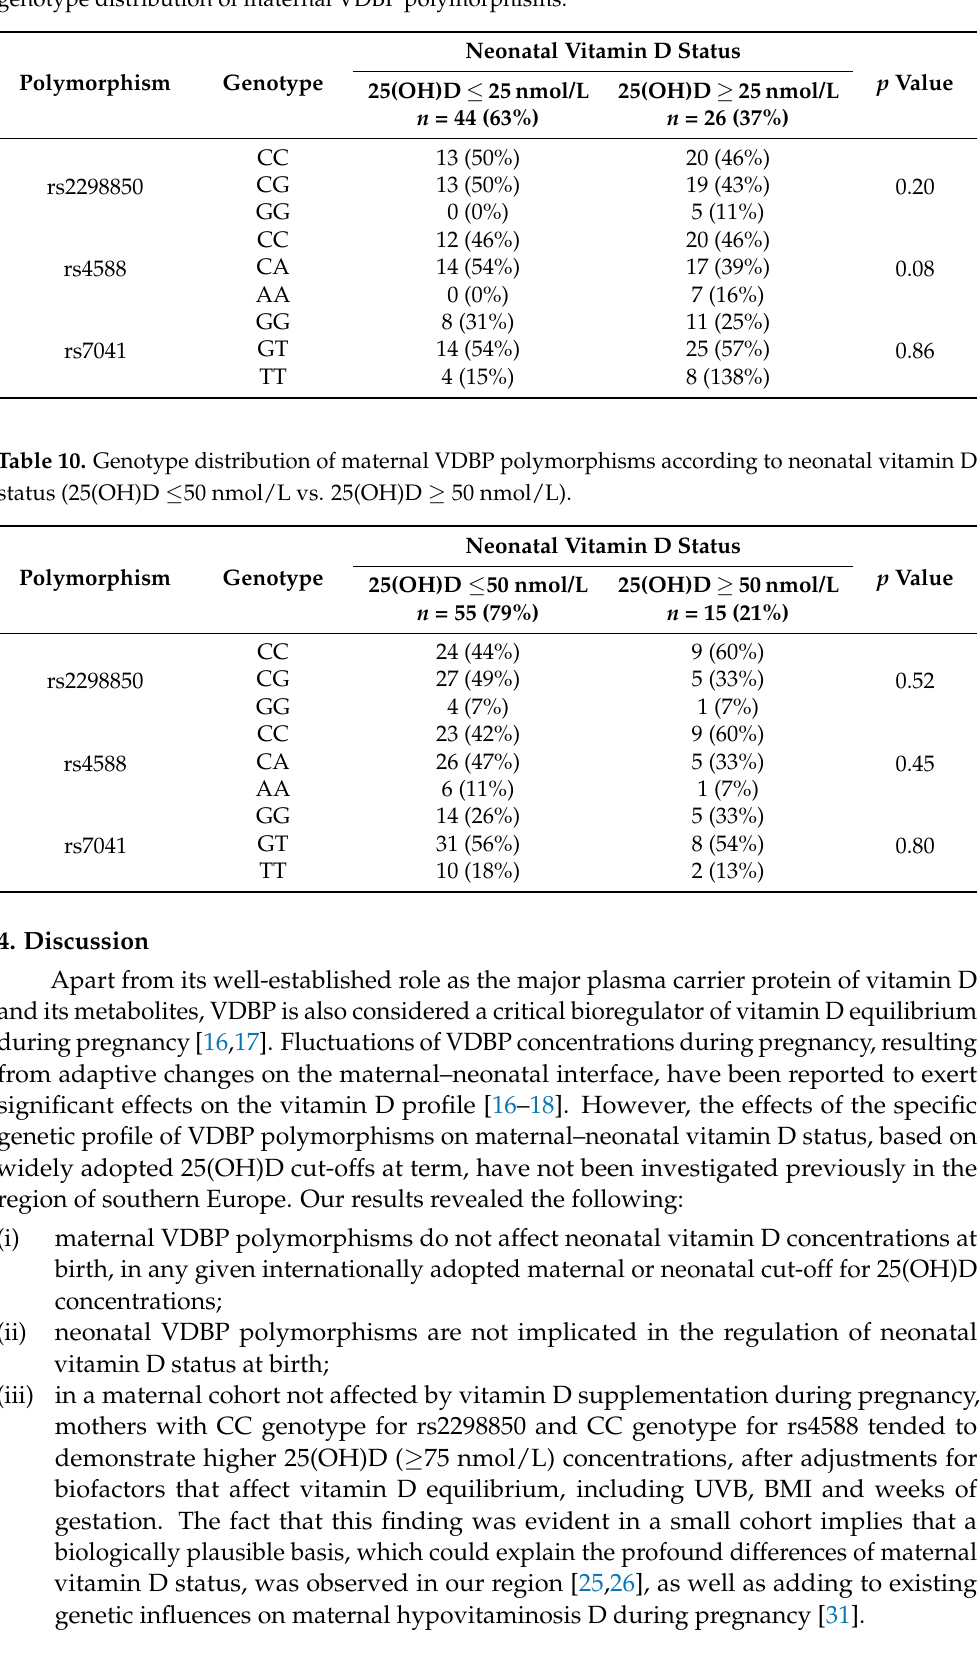
Table 9. Neonatal vitamin D status (25(OH)D ≤ 25 nmol/L vs. 25(OH)D ≥ 25 nmol/L) according to genotype distribution of maternal VDBP polymorphisms.